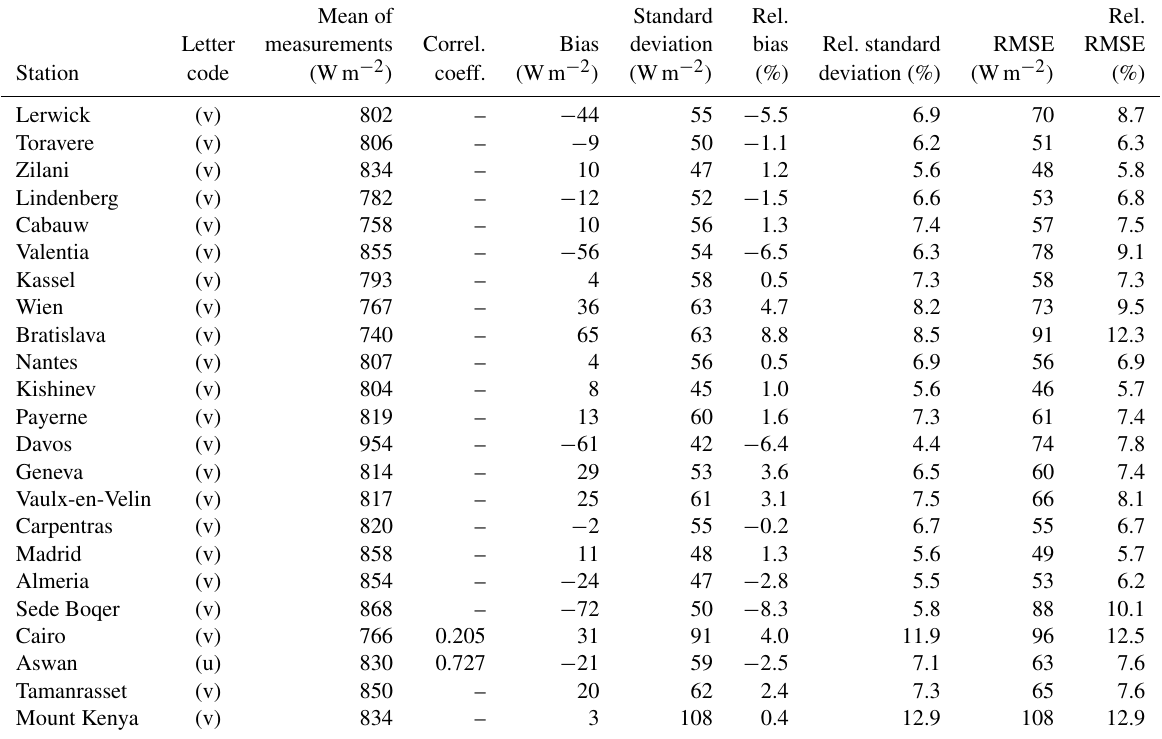
Table B6. Results from previous works at summarization 1h. Means of the measurements, correlation coefficients, bias, standard deviations, RMSE, and their values relative to the mean of the measurements for B N . Mean of Standard Rel.